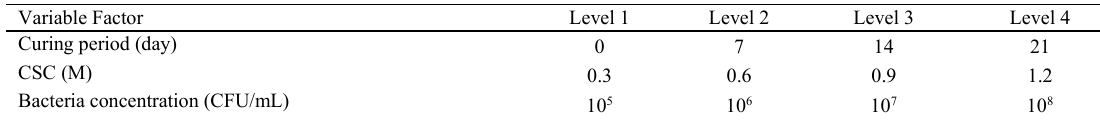
Table 2: Different levels of the studied factors